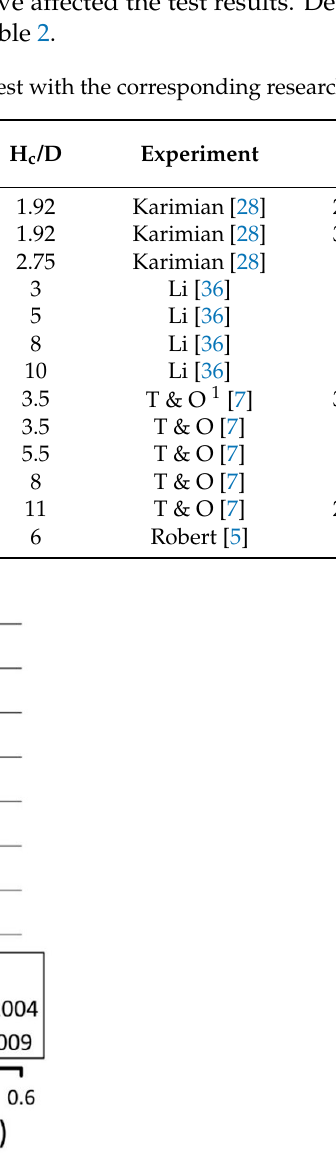
Figure 3. Dimensionless force vs. displacement test data for dense sand (16.7 kN/m 3 < γ d ≤ 17.5 kN/m 3 ). Experiments performed by